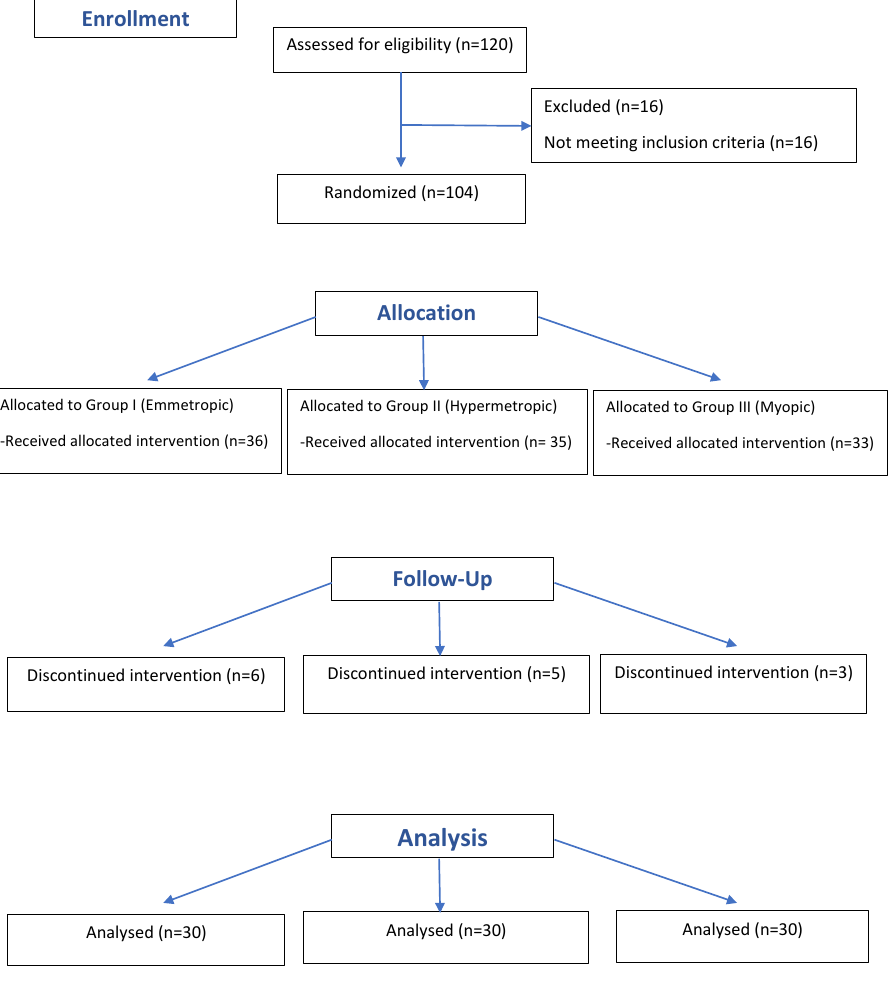
Figure 1. Consort flow diagram of the study.